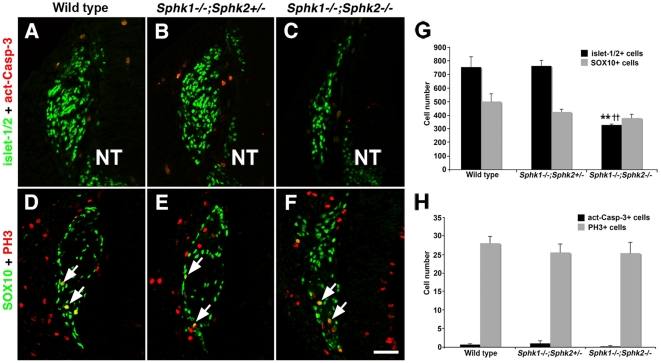
Ablation of Sphk1 and Sphk2 affects neuron but not progenitor cell numbers in E10.5 dorsal root ganglion.(A–C) Transverse trunk sections from wild type, Sphk1−/−;Sphk2+/−, and Sphk1−/−;Sphk2−/− immunostained with islet-1/2 (green, nuclear) and act-Casp-3 (red). Wild type (A) and Sphk1−/−;Sphk2+/− (B) DRG appear similar in shape and size. Sphk1−/−;Sphk2−/− DRG (C) is smaller and has fewer neurons. Few act-Casp-3+ cells are observed in DRG from all three genotypes. (D–F) Adjacent sections to those used in (A–C) were processed for PH3 (red) and SOX10 (green, nuclear) immunofluorescence. The shapes of the DRG are similar in wild type (D) and Sphk1−/−;Sphk2+/− (E); most SOX10+ cells are located in the periphery of the ganglion. Sox10+ cells in Sphk1−/−;Sphk2−/− DRG are no longer restricted to the periphery of the ganglion. PH3+ (green) cells can be found in DRG from all genotypes examined and some of them are also SOX10 positive (arrow). (G) Quantification of cell number in E10.5 DRG demonstrates that there are 24% fewer SOX10+ cells in Sphk1−/−;Sphk2−/− DRG compared to wild type and Sphk1−/−;Sphk2+/− but this reduction is not statistically significant (p = 0.079). The double mutant DRG shows a 56% reduction in the number of neurons compared to wild type and Sphk1−/−;Sphk2+/− embryos. n = 3 embryos from each genotype; **  = Sphk1−/−;Sphk2−/− to wild type comparison, p <0.01. ††  = Sphk1−/−;Sphk2−/− to Sphk1−/−;Sphk2+/− comparison, p<0.01. (H) Quantification of total number of dying (act-Casp-3+) and dividing (PH3+) cells. Cell count results reveal no significant difference in cell death and proliferation in Sphk1−/−;Sphk2−/− DRG compared to wild type and Sphk1−/−;Sphk2+/− at this stage. NT = neural tube. Scalebar for A–F =  50 µm.